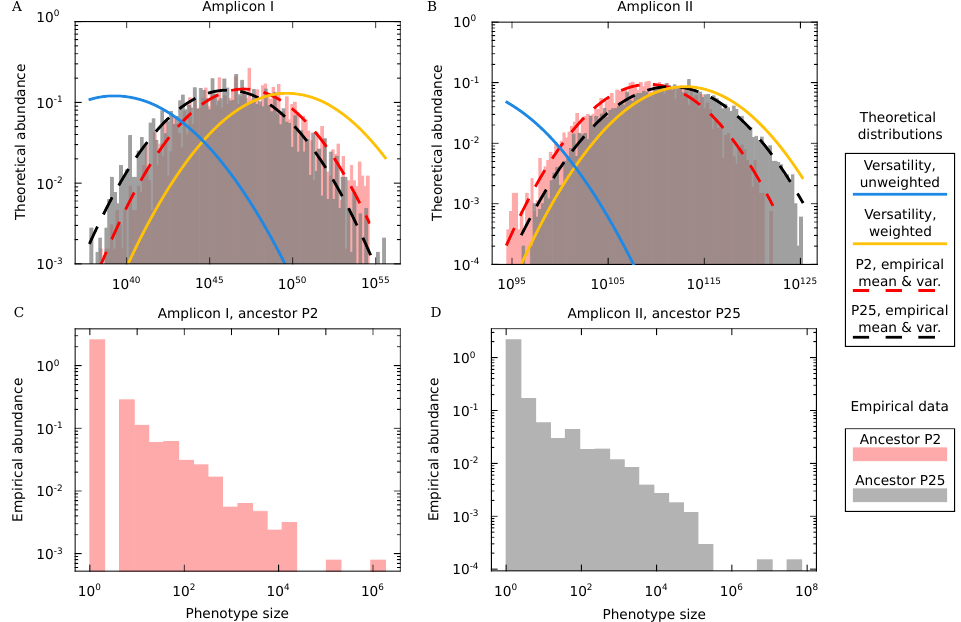
Figure 6. Empirical versus theoretical distributions of phenotype sizes. ( A , B ) Abundance distribution of protein sequence (phenotype) sizes calculated with various approaches, as shown in the legend and explained in the main text for amplicon I ( A ) and amplicon II ( B ). ( C , D ) Abundance distribution of empirical protein sequences calculated as the sum of different empirical haplotypes (nucleotide sequences) that map to the considered protein. All mutations in the nucleotide sequence must, therefore, be silent. These distributions decay from a maximum at size 1 and have fat tails. Two examples are shown: one corresponding to amplicon I that evolved from ancestor P2 ( C ) and one corresponding to amplicon II that evolved from ancestor P25 ( D